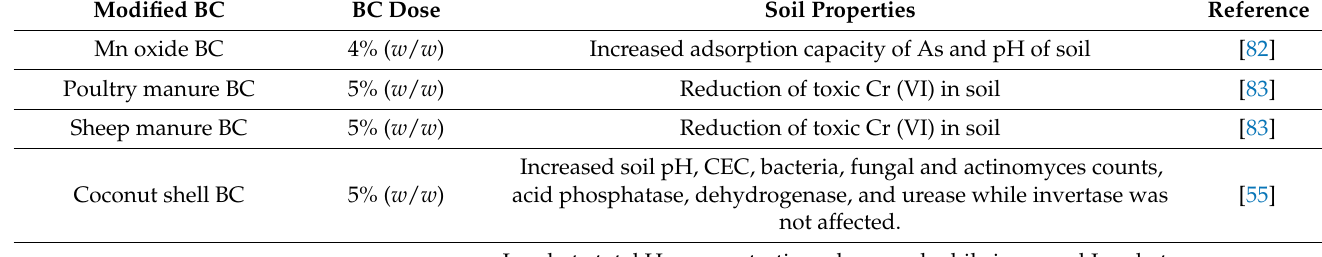
Table 1. Efficacy of modified biochar in improving soil